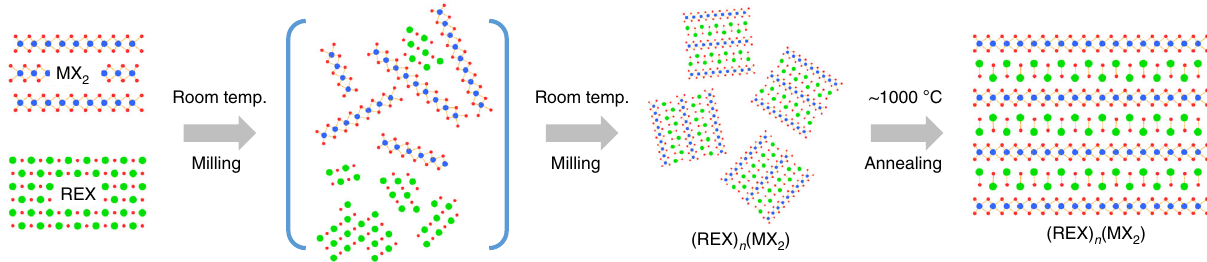
Fig. 3 Schematic representation of 3D heterostructures synthesis. Mechanochemical synthesis of (REX) n (MX 2 ) heterostructures, where RE = rare earth; M = Ta or Nb; X = S or Se; and n values vary between 1 and 1.2.